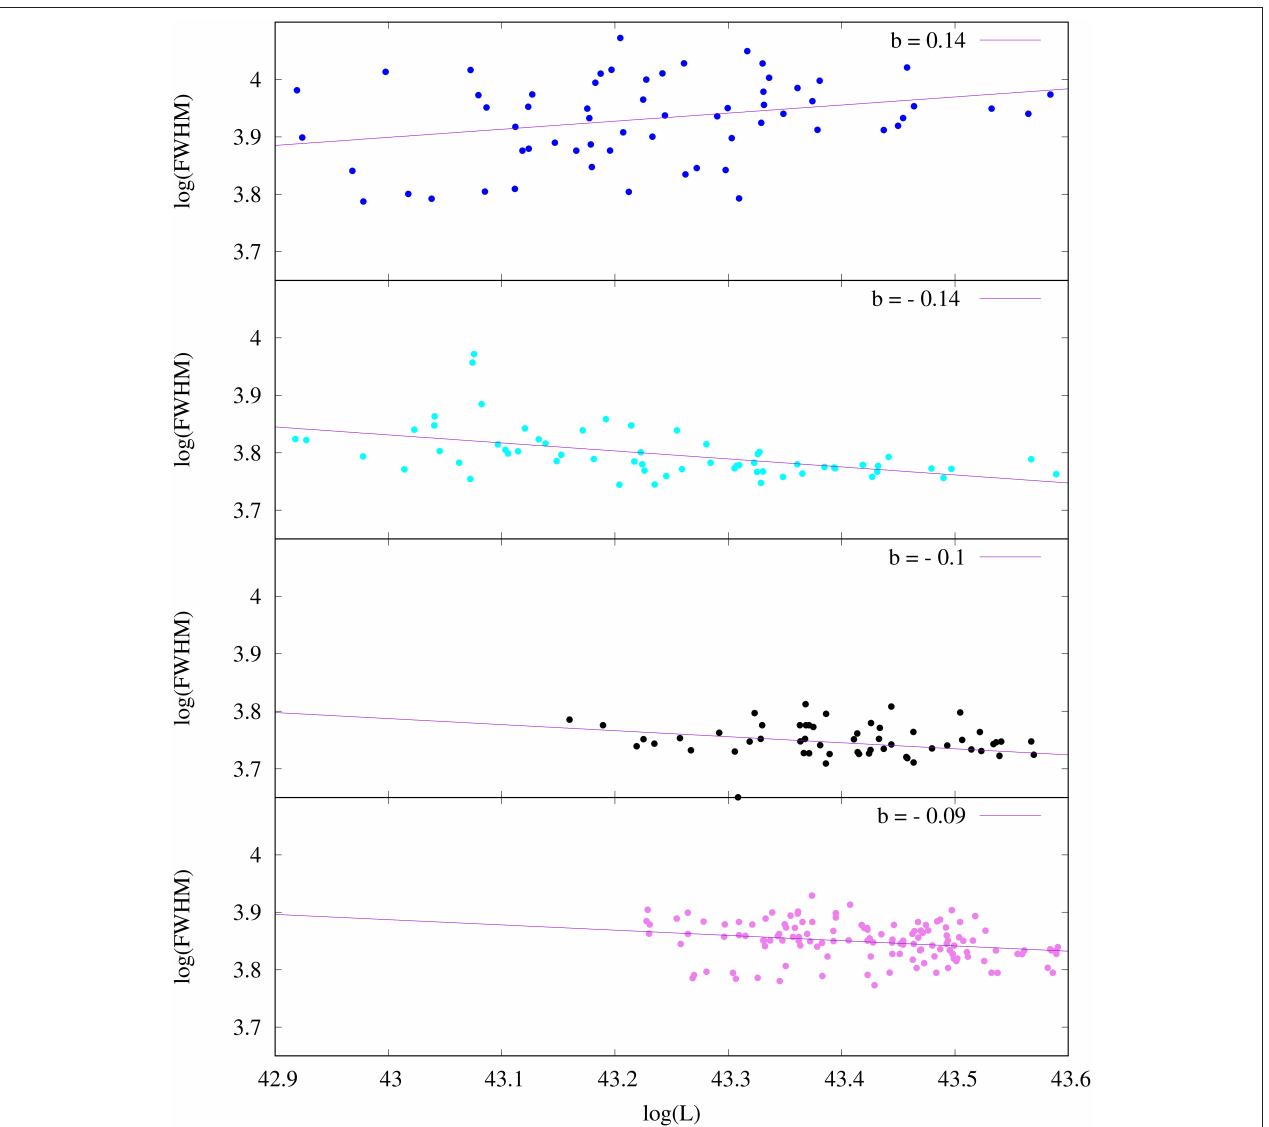
FIGURE 7 | Trends of luminosity against FWHM of H β for long term (blue represents last 12 years of observations) and short term variations (cyan, black, and pink are order of months). Lines shows an unweighted least squares fit. Colors of data points correspond to those presented in the Figure 1 . Values of slope trends are marked on each